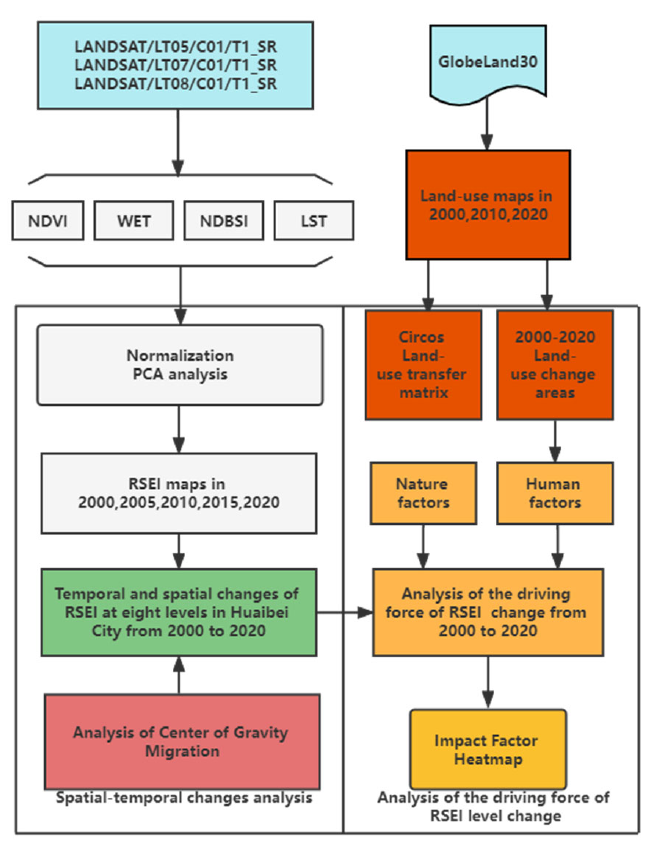
Figure 2. Workflow Figure 2. Workflow chart.